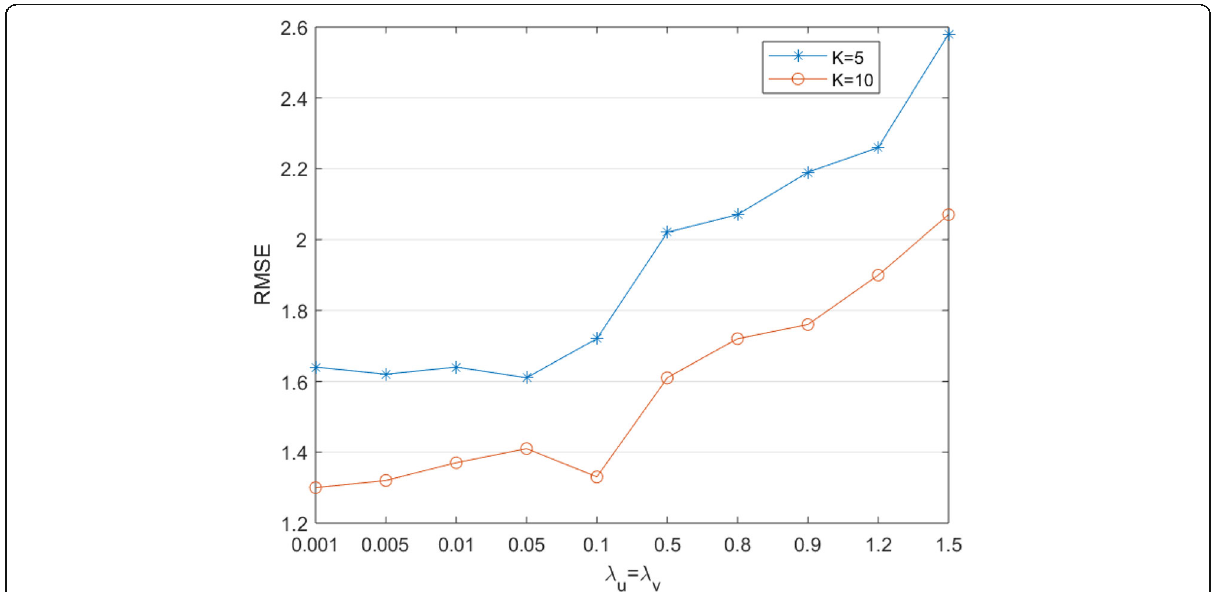
Fig. 4 RMSE vs. λ u and λ v on Epinions. The blue line with K = 5, and the green line with K =